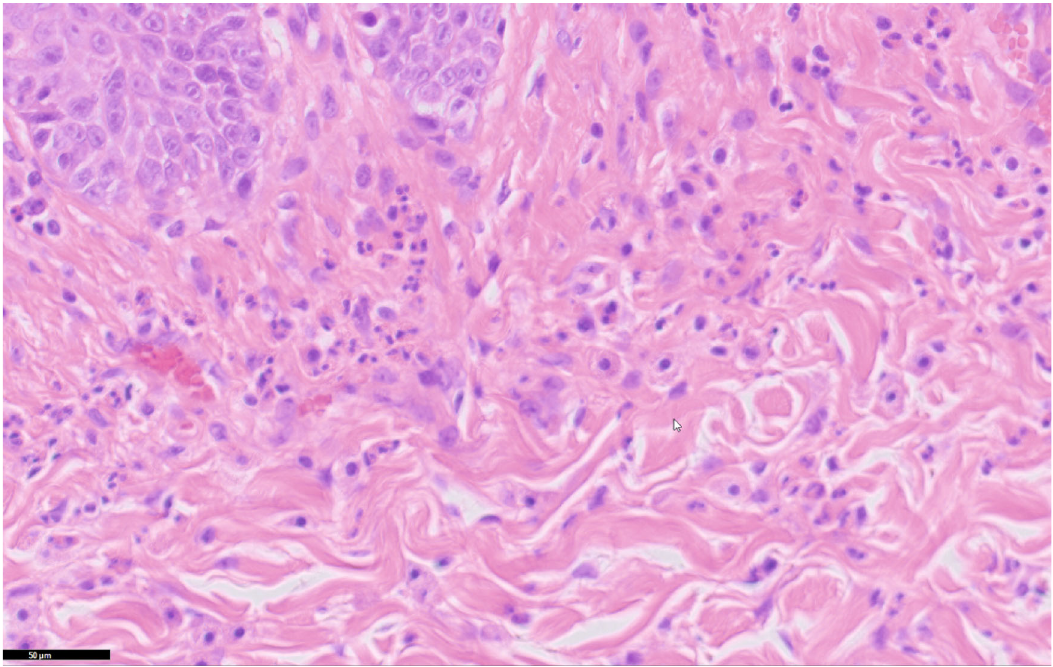
Figure 2: Hematoxylin and eosin photomicrograph ( × 40) showing eosinophils and mast cells in the dermis (courtesy of IDEXX Laboratories).